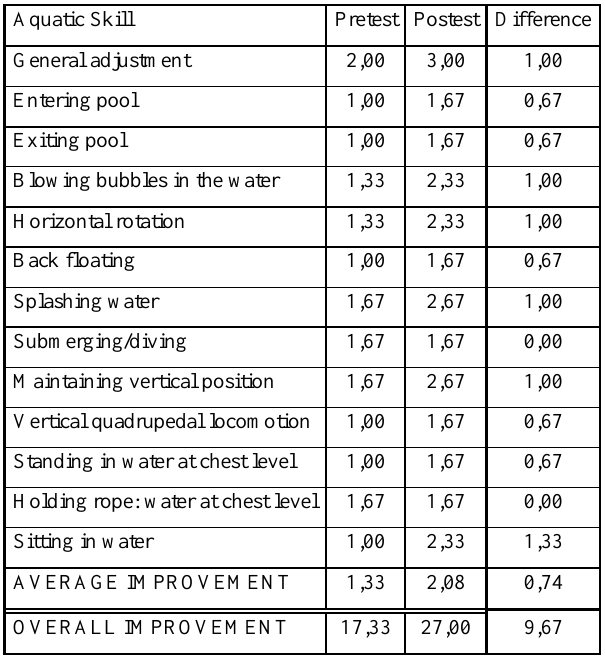
Table 2 Results for Students with Quadruparetic form of Cerebral Palsy Aquatic